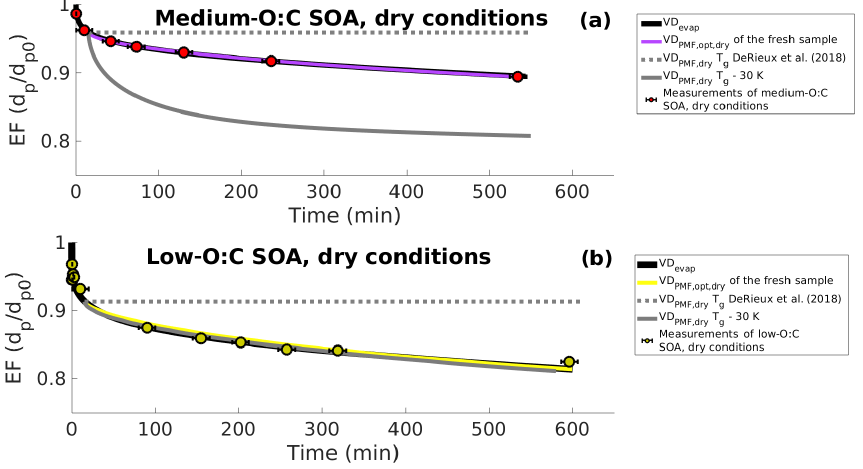
Figure 8. Evapograms showing the measured isothermal evaporation of (a) medium-O : C SOA and (b) low-O : C SOA in dry-condition experiments (markers and black whiskers) together with the simulated evapograms. The best-fit simulated evapogram calculated with VD evap (obtained from high-RH experiments) and optimizing b i is shown with a solid black line. Gray lines show the minimum and maximum possible evaporation calculated, with the VD PMF , dry (C ∗ of PMF factors calculated from T max ) at the highest (the original parametrization of DeRieux et al., 2018; dashed gray lines) or the lowest (30K subtracted from the T g of every ion; solid gray line) studied viscosity. Solid purple and yellow lines show the best-fit simulated evapograms calculated with the optimized VD PMF , opt , dry (based on the assumption that the FIGAERO sample represents particles at the mean of the sample collection interval) and b i restricted (based on the DeRieux et al., 2018, parameterization). The figure shows, similar to Fig. 5, that the volatility distribution determined from the FIGAERO–CIMS data with the PMF method is consistent with the measured evaporation of the SOA particles once the uncertainty in the effective saturation concentration and the glass transition temperature parametrization of DeRieux et al. (2018) are